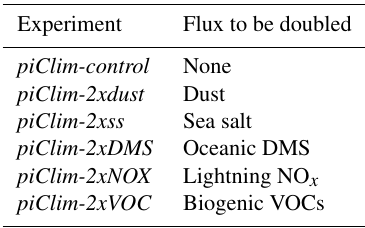
Table 1. List of simulations for diagnosing ERFs of natural emitted species. The specified natural emission fluxes are doubled compared to the 1850